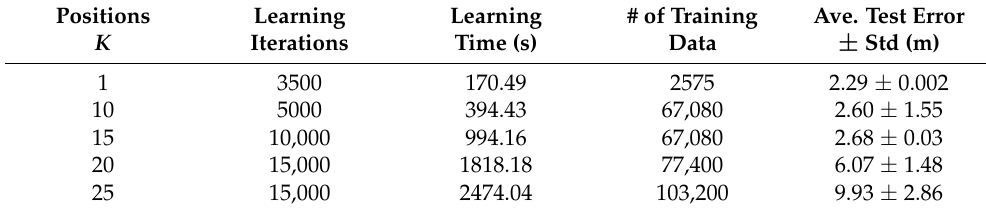
Table 2. Experimental